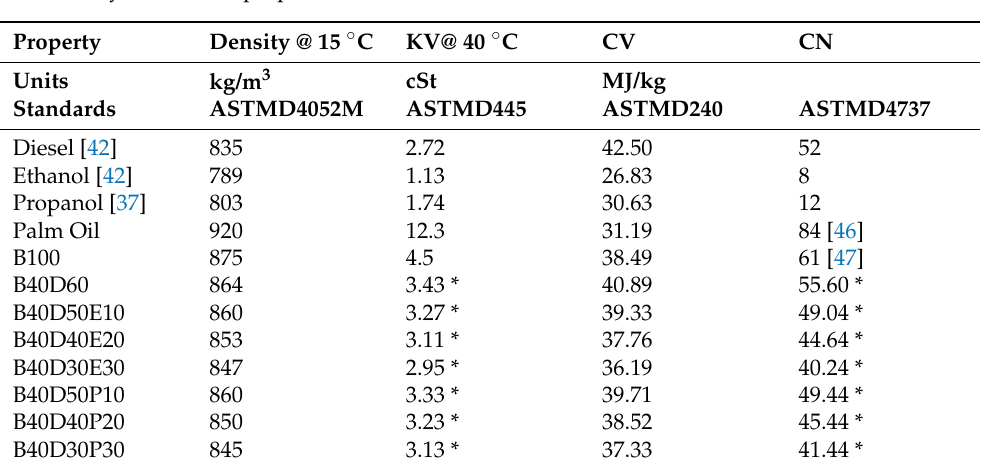
Table 4. Physiochemical properties of various fuels.